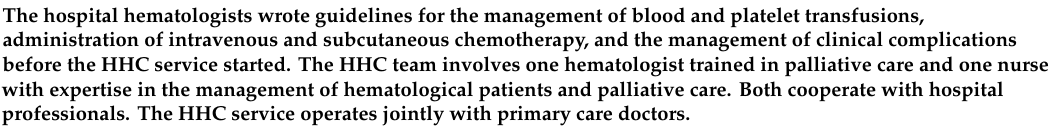
Table 1. Reggio Emilia health district hematological home care service